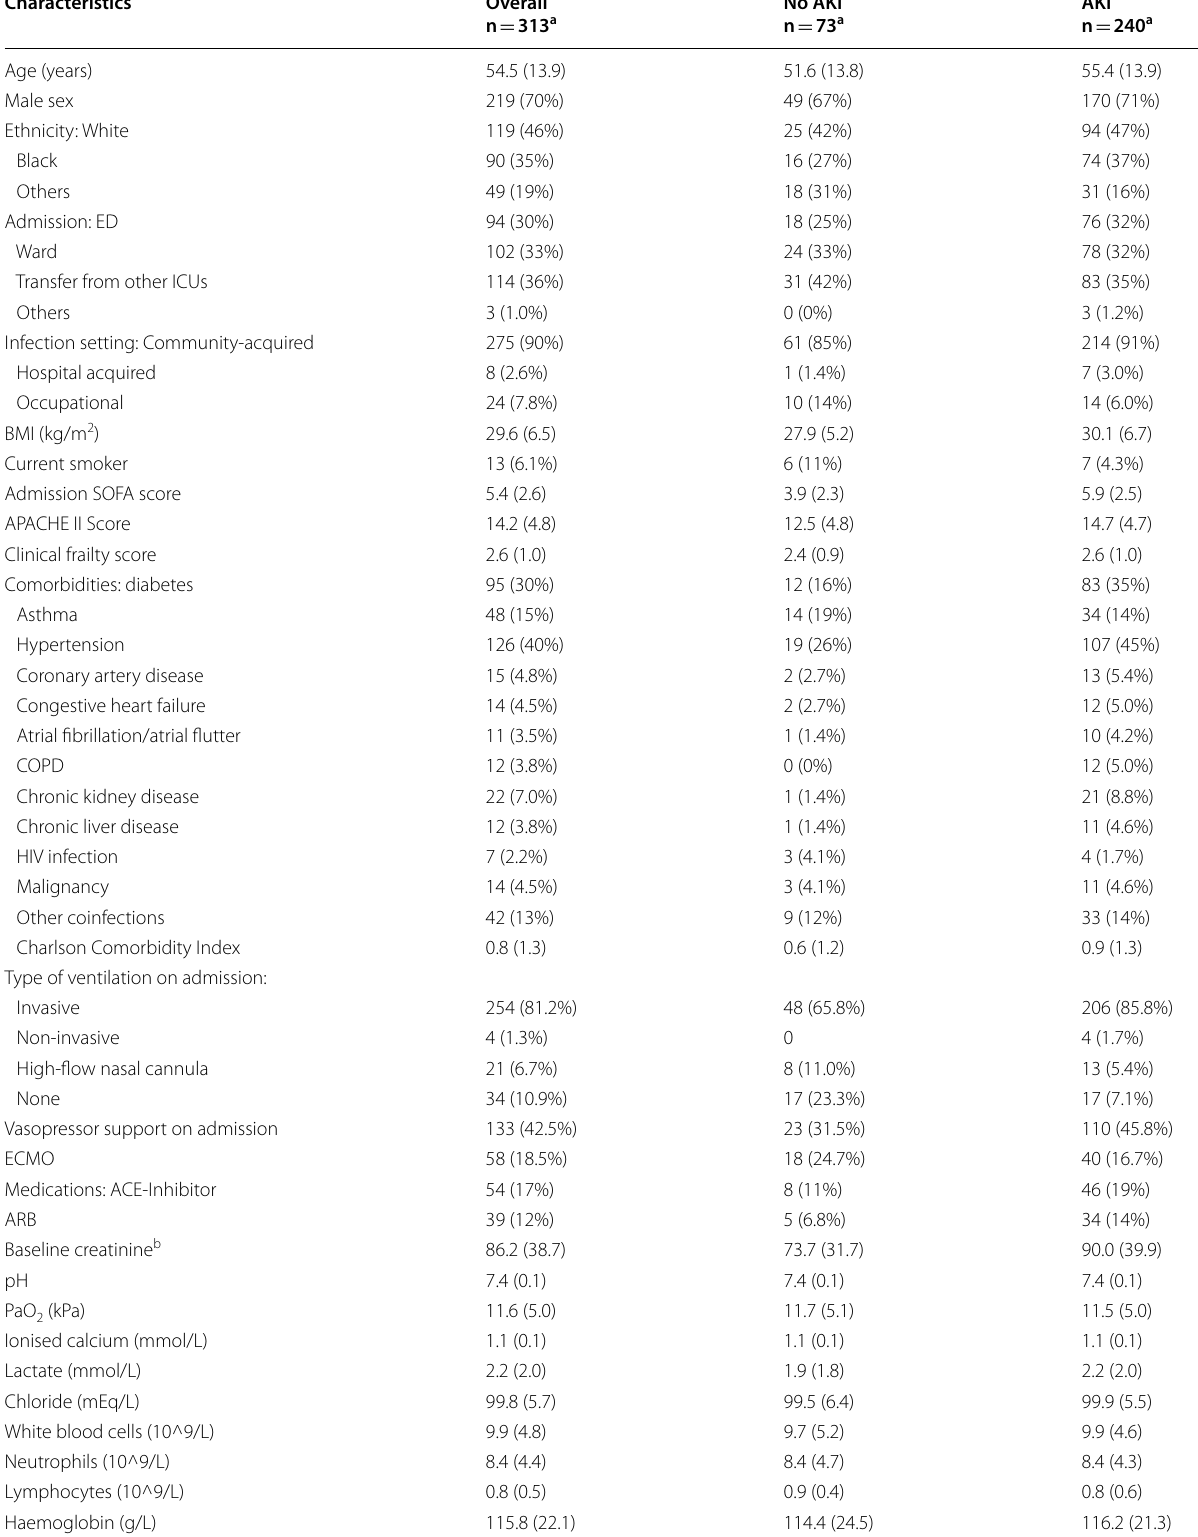
Table 1 Baseline characteristics of patients and final acute kidney injury status